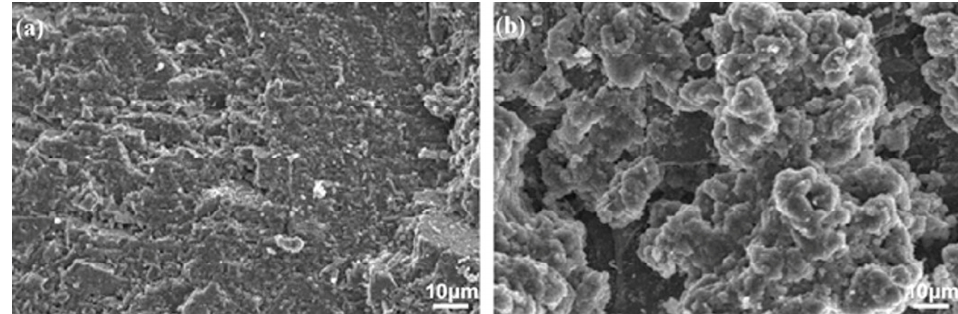
Figure 7. SEM images of ( a ) untreated marble and ( b ) marble covered by a superhydrophobic, water repellent composite (the silica/siloxane mass ratio was 0.4). Reprinted with permission from [39]. Copyright 2013 John Wiley and Sons.